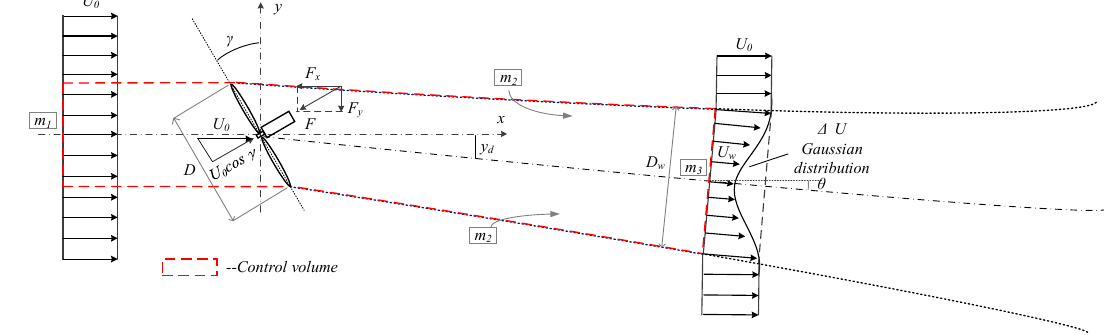
Figure 8. Schematic of the momentum conservation-based model for the wake deflection. Black dotted lines downstream the turbine represent the wake boundaries and the part overlapped by the red dashed lines are used to establish the control volume.